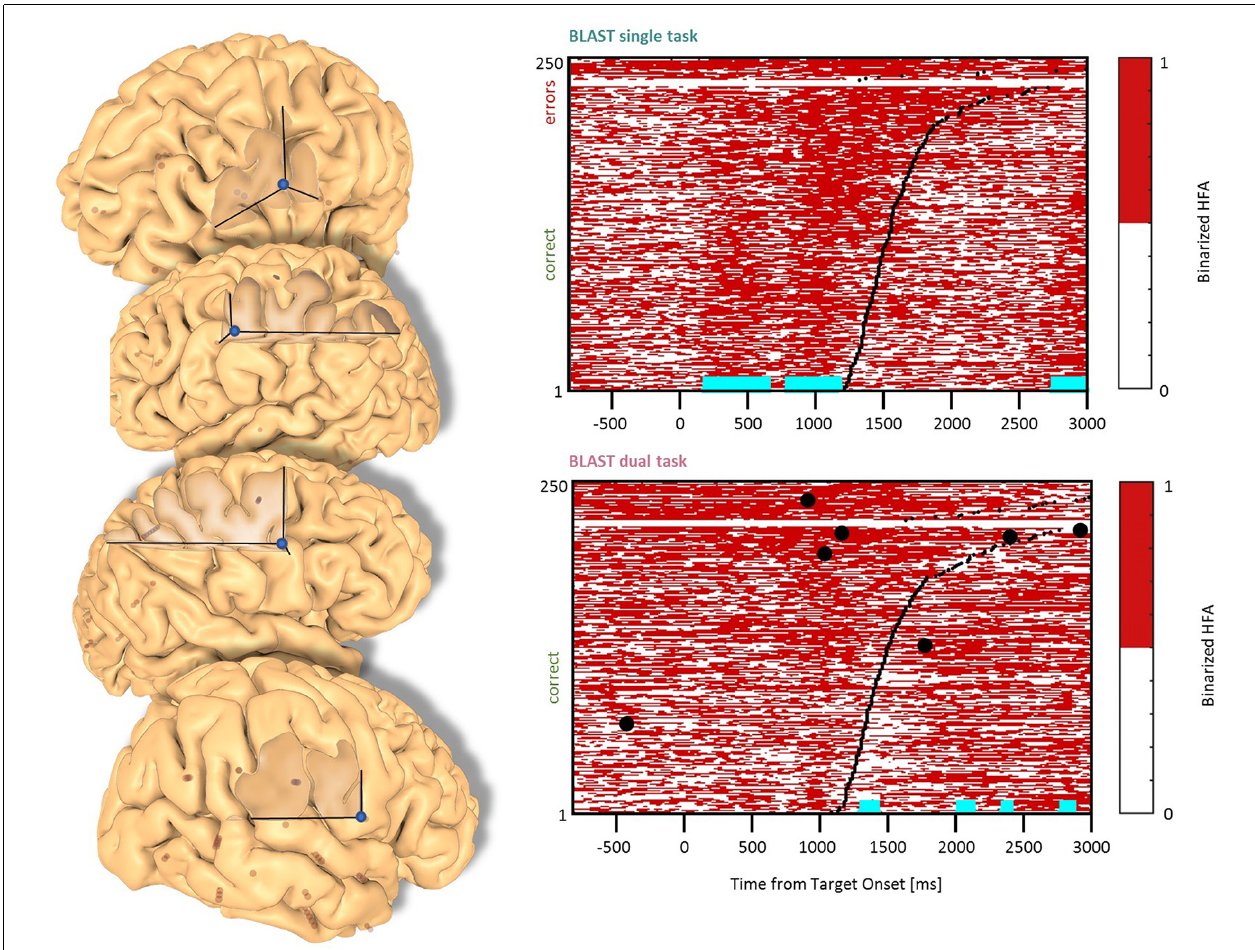
FIGURE 3 | Interference in the Precentral Cluster. Sites with interference between T1 and T2 are displayed at their precise anatomical location onto a 3D representation of the participant’s brain. The matrix representation reproduces the display of Figure 2 , for the single-task and dual-task conditions for one of the sites. Patients id [Px] and iEEG site names, from left to right and top to bottom: R’9 [P4]; S’9 [P5] (matrix displayed); M9 [P2]; R9 [P1].